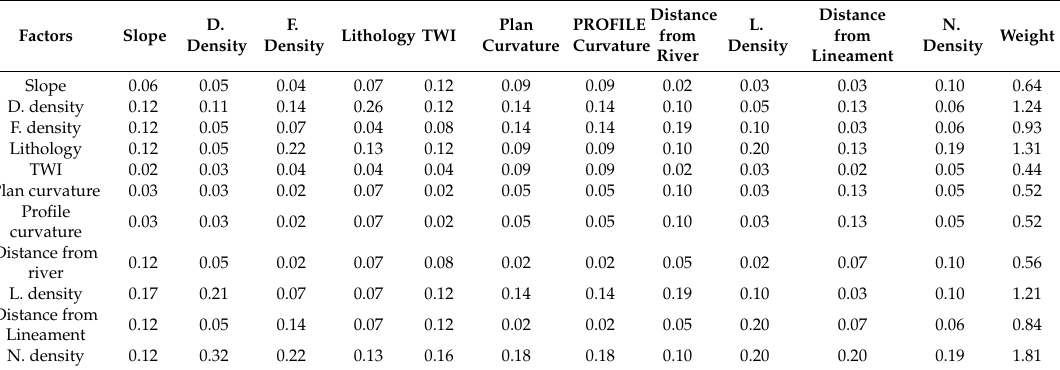
Table 4. Determining the normalized weights for each thematic layer.